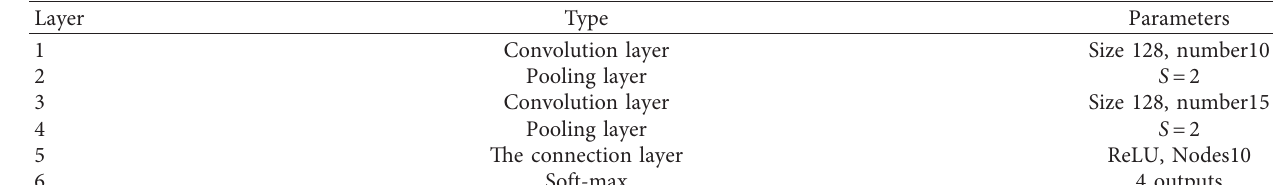
Table 4: Main structure of DCNN.